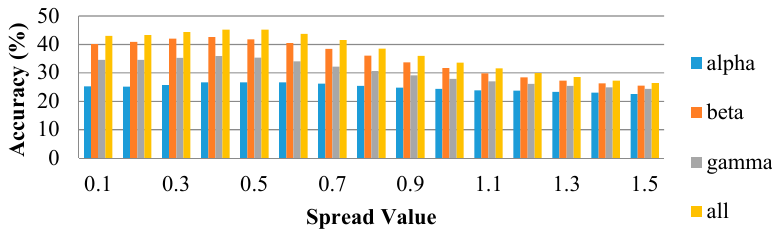
Figure 12. Average classification performance of bispectrum features by varying spread values for the RBD group using PNN.